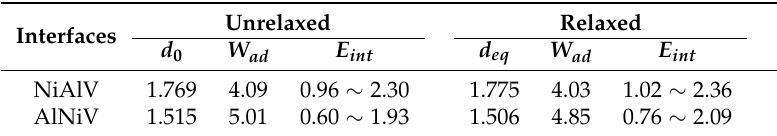
Table 5. Interfacial distance d 0 (Å), work of adhesion W ad (J/m 2 ) and interface energy E int (J/m 2 ) using two different